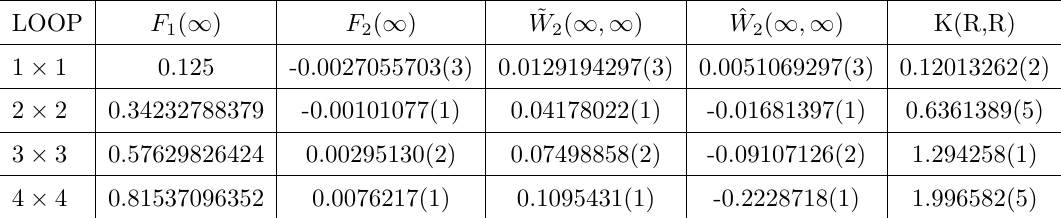
Table 1. Values at in(cid:12)nite volume of the functions F 1 and F 2 de(cid:12)ned in the text. The next three columns are combinations of these numbers giving the second order coe(cid:14)cients ~ W 2 and ^ W 2 at large N , as well as the parameter K of ref. [11].